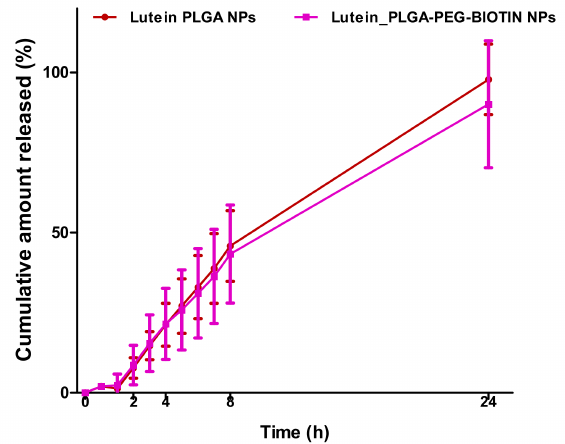
Figure 5. In-vitro release of lutein from lutein-loaded PLGA and PLGA–PEG–biotin NPs. Data are expressed as means ± SDs (n =